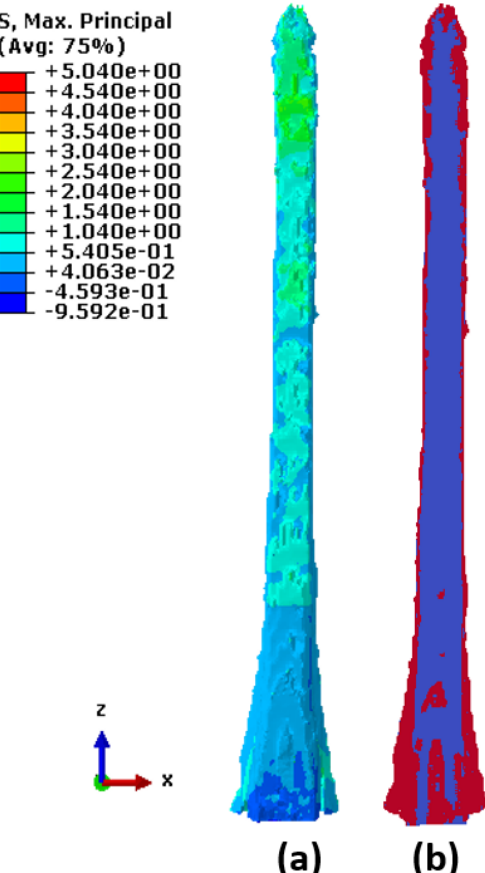
Figure 14. Soft cartilage of paddlefish rostrum. ( a ) Maximum principal stress obtained from finite element analysis. ( b ) Minimum cut obtained from mathematical analysis on bottom surface of rostrum’s soft cartilage. Nodes are colored by their respective locations on the source (red) or sink (blue) side of the minimum cut.